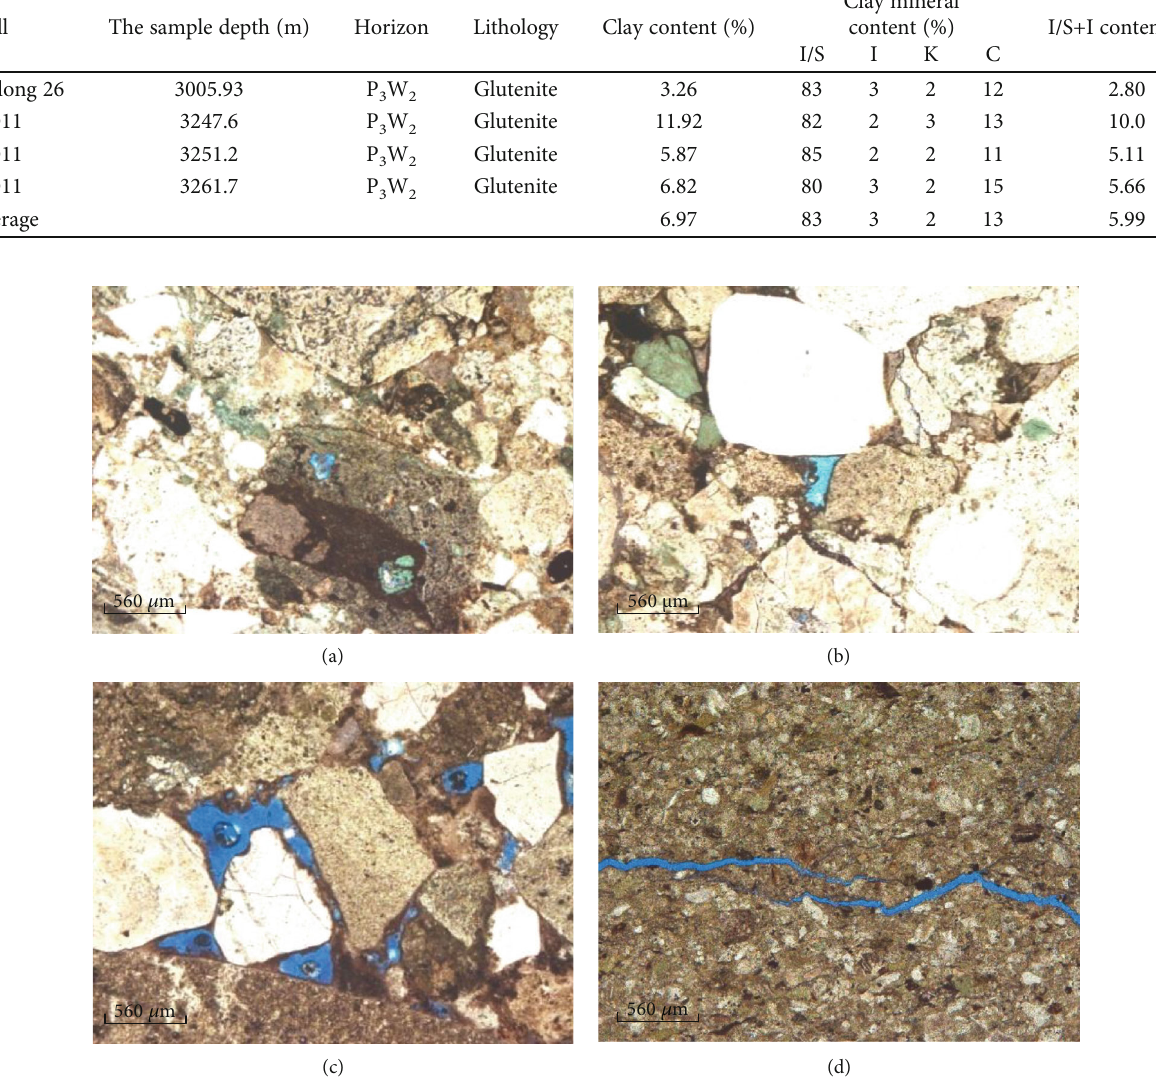
Figure 2: Photograph of a thin slice of the Wu 2 section in the Ke017 well area. (a) Jin long 26, 3006.9m, intragranular pores; (b) Jin long 26, 3009.75m, residual intergranular pore; (c) Mahu 8, 3353.2 m, residual intergranular pore; (d) Jin long 26, 3005.41m,